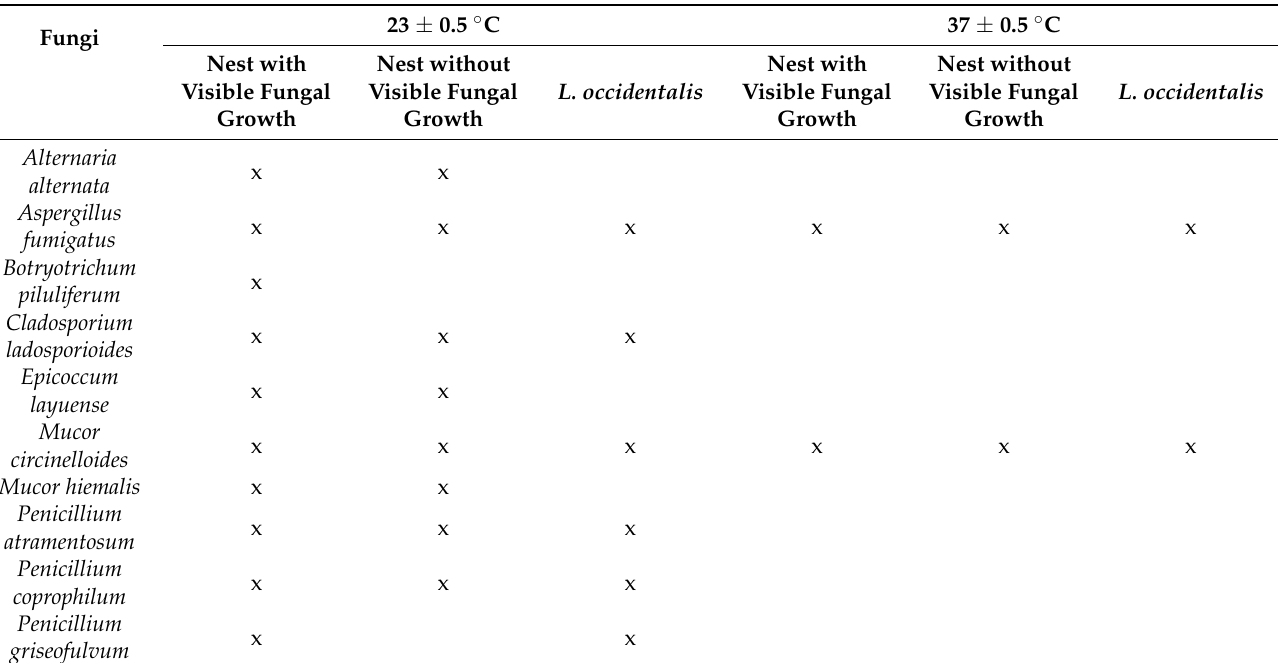
Table 2. Fungi isolated from grey heron nest fragments with/without fungal growth or from nest inhabiting insects ( Leptoglossus occidentalis ): x = the fungus was cultured from the